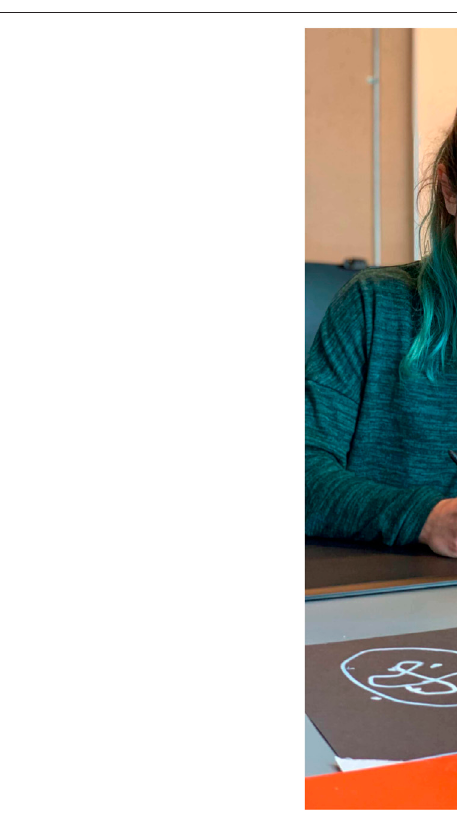
FIGURE1| RizzointheHRIlab,experimentingforthe fi rsttimewithteleoperatingtheUR3usingastylusanddigitaltablet.Theprogramhadseveralmodes:mirror, follow, and